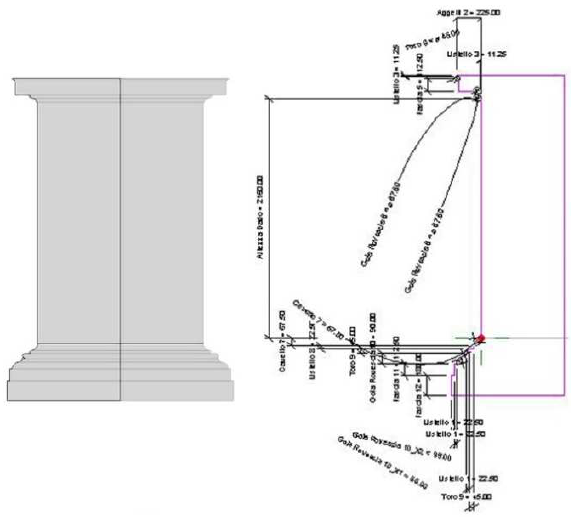
Figure 4. Pedestal profile (4A. Geometrical outline, 4B. Tags - Instance